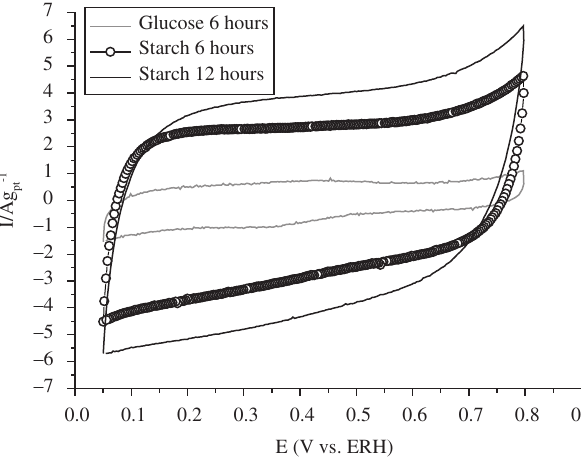
Figure 3. SEM micrographs of PtRu/Carbon materials after thermal treatment a) glucose 6 hours; b) starch 6 hours; and c) starch 12 hours.